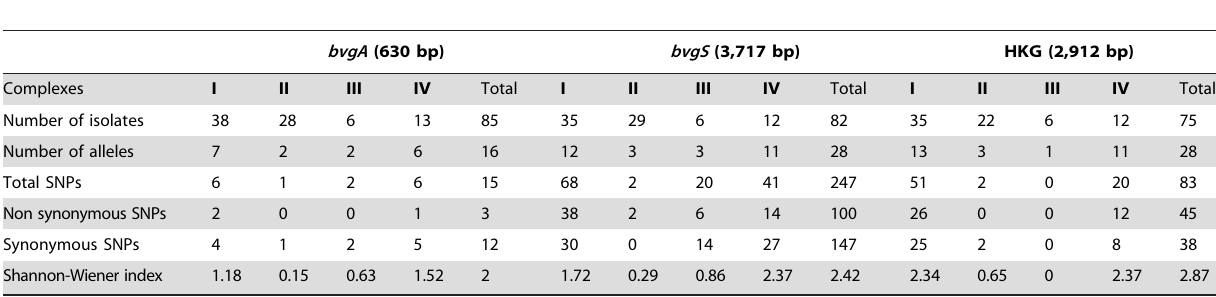
Table 1. Numerical analyses of the sequence